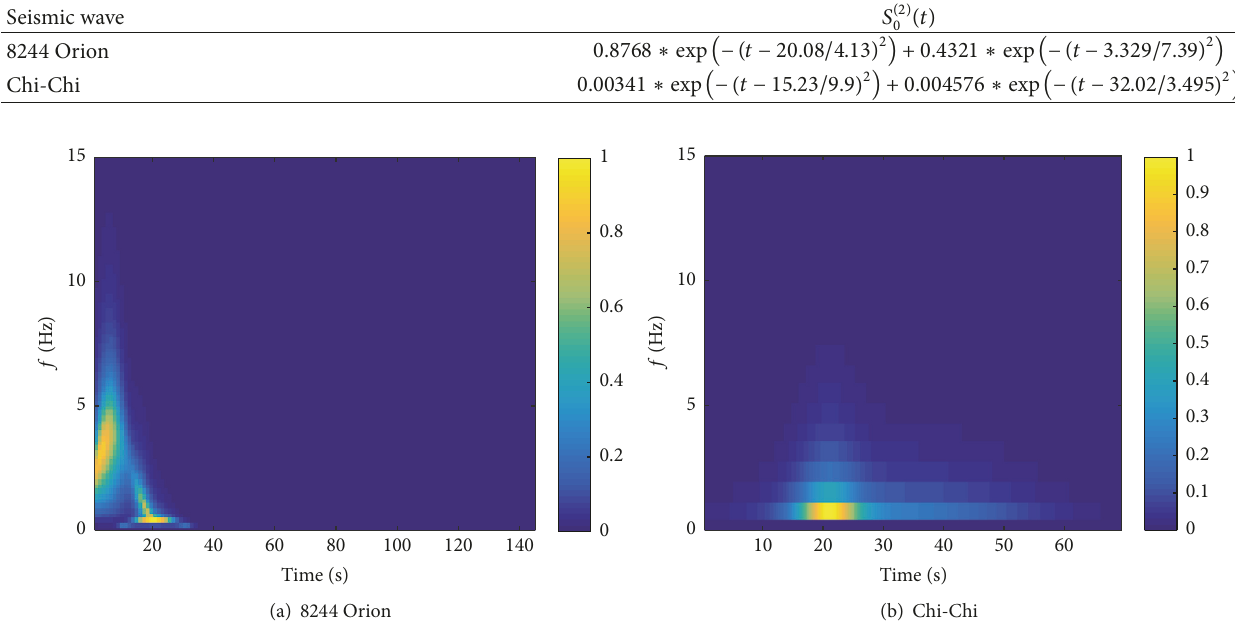
Figure 8: Time-varying power spectra of the ground motions from the bimodal Kanai-Tajimi model inverse